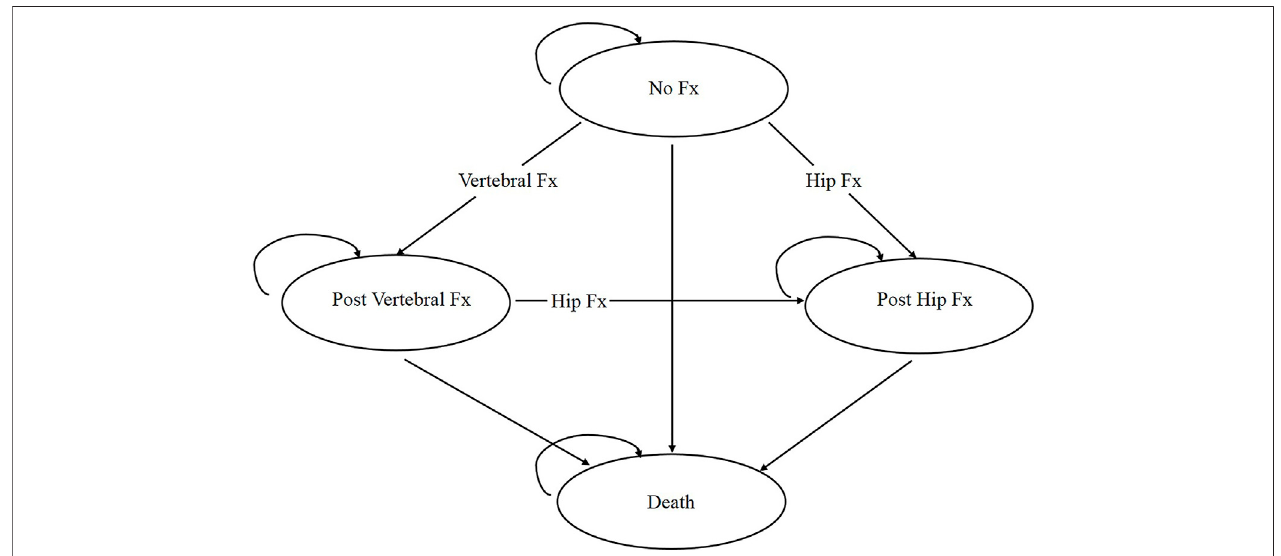
FIGURE 1 | Simpli fi ed structure and transitions of the Markov